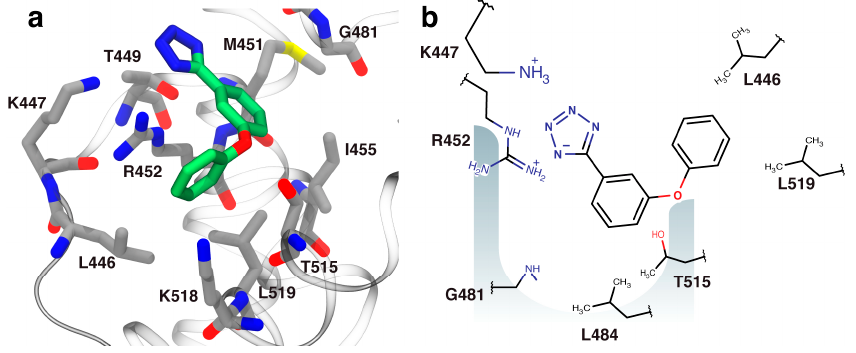
Figure 7. ( a ) Docked binding pose of 6 (green carbon atoms) bound to DnaGC (gray carbon atoms). ( b ) Schematic representation of interactions.